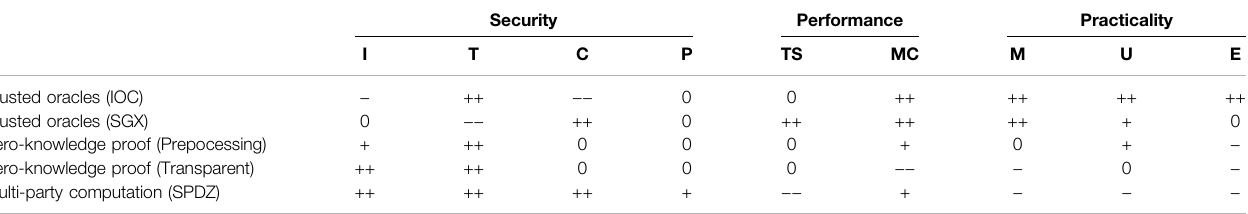
TABLE2| GradedevaluationresultsofselectedVCschemesregardingthefollowingevaluationcriteria: I ntegrity , T ransparency , C on fi dentiality , P rivacy , T ransaction S peed , M emory C onsumption , M aturity , U sability , and E xtensibility